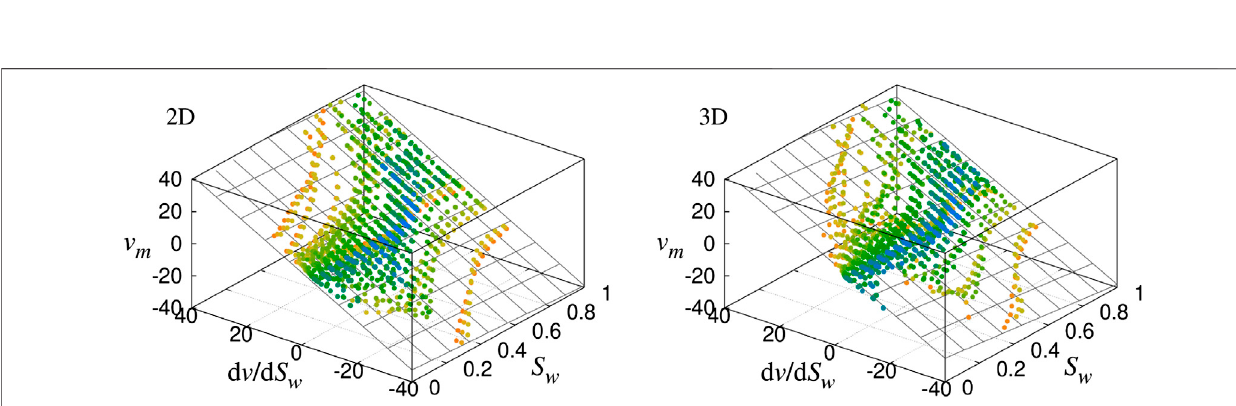
Frontiers in Physics |